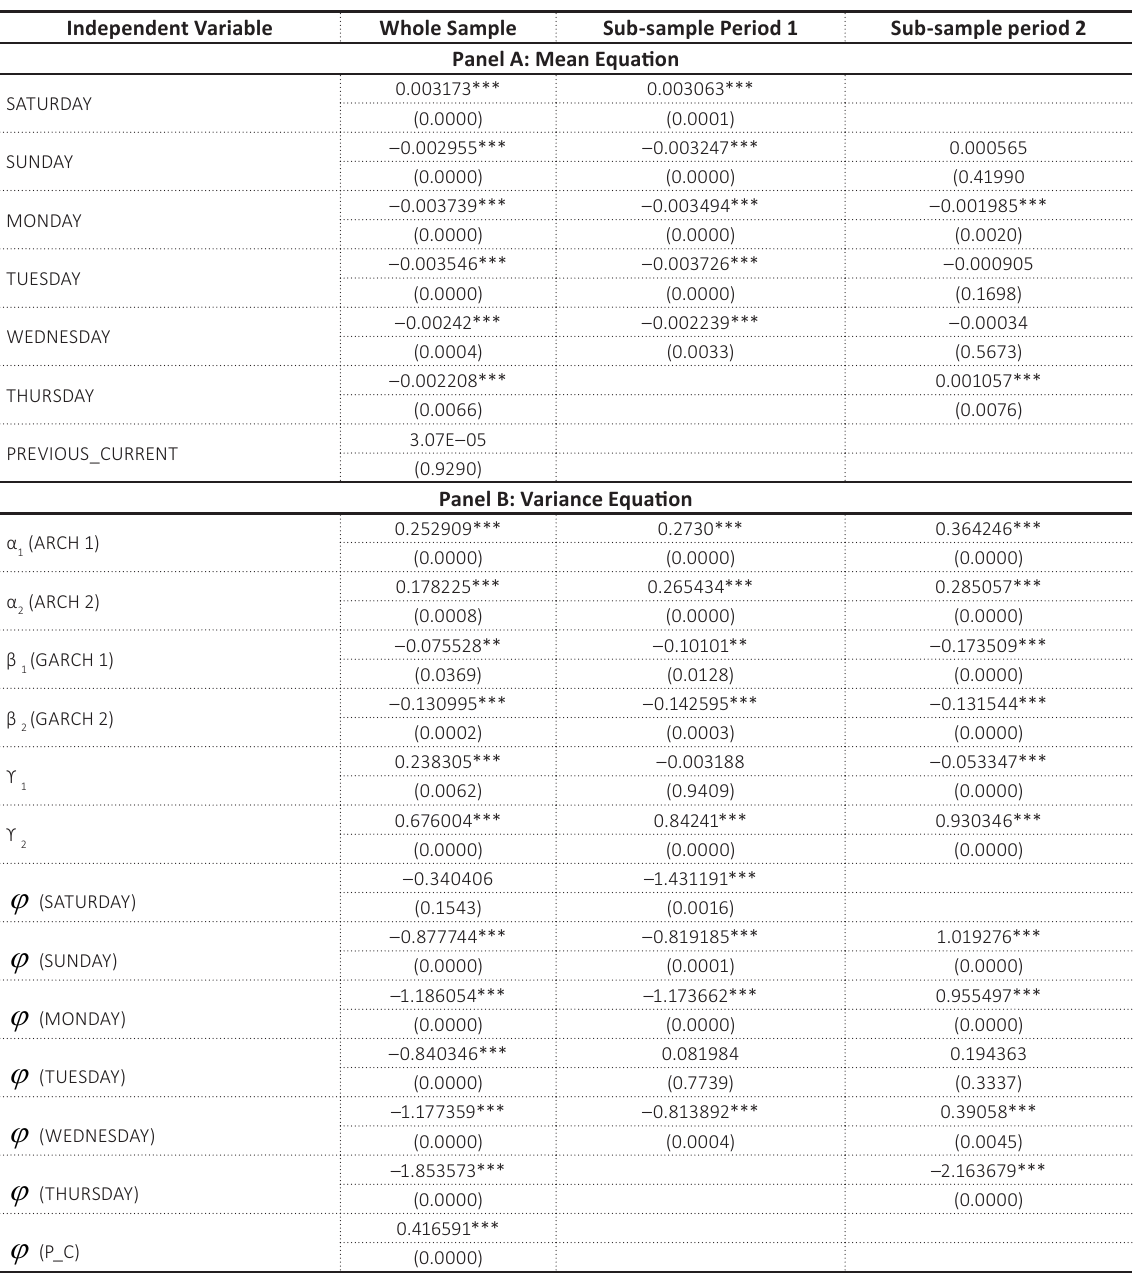
Table 3. EGARCH (2, 2) mean and variance